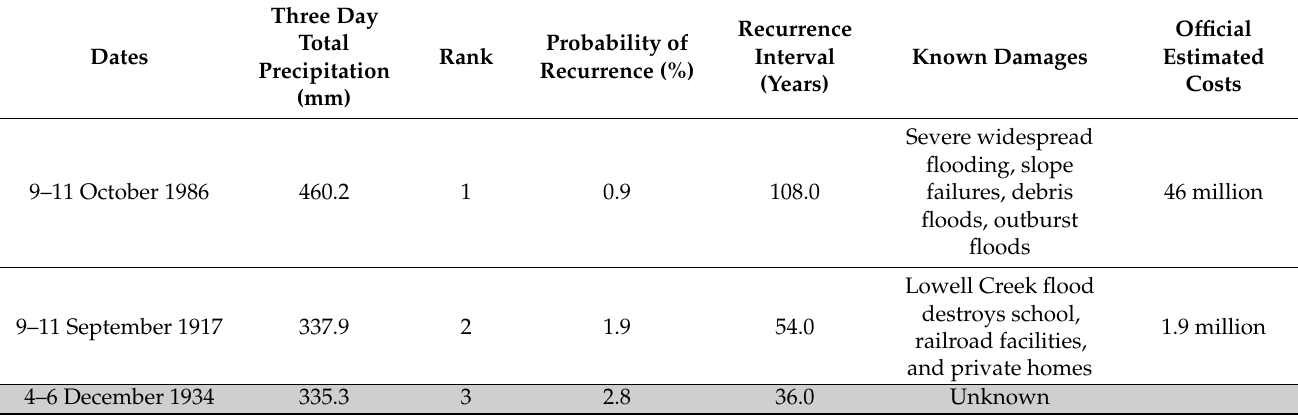
Table 2. Total three-day precipitation amounts with recurrence interval and known damage for Seward Alaska, 1908–2018. Dollar amounts are adjusted for inflation to 2018 values. Winter snow storm events are highlighted in